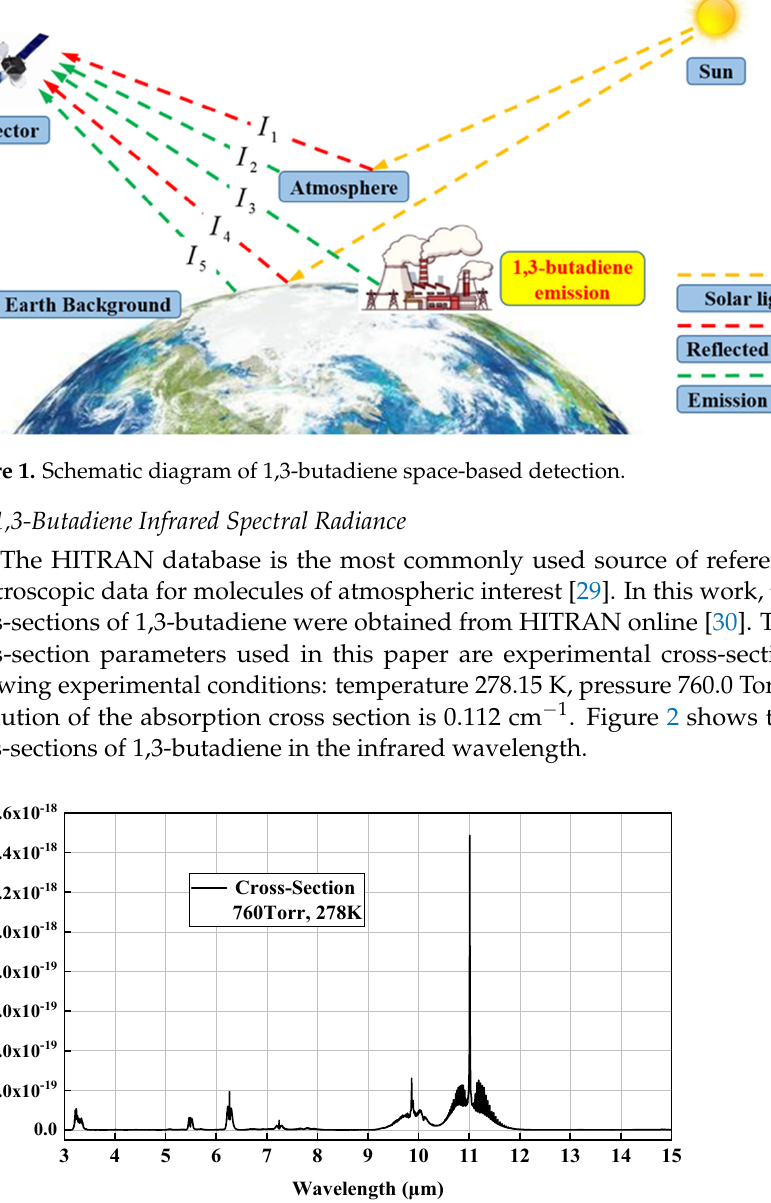
Figure 2. 1,3-butadiene absorption cross sections from the HITRAN database 2020.